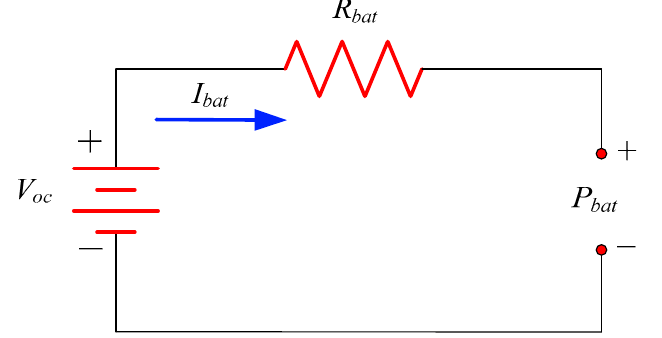
Figure 7. The simplified internal resistance battery model.